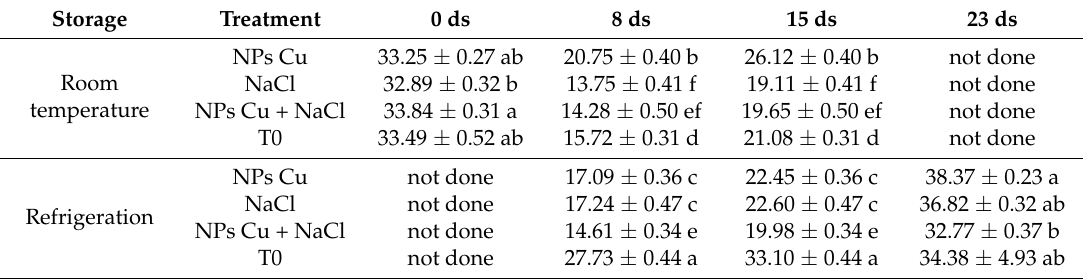
Table 5. Vitamin C content (milligrams of ascorbic acid per 100 g fresh weight) in tomato fruits at different storage times at room temperature (24 ± 1 ◦ C) and refrigeration (4 ± 1 ◦ C and relative humidity at